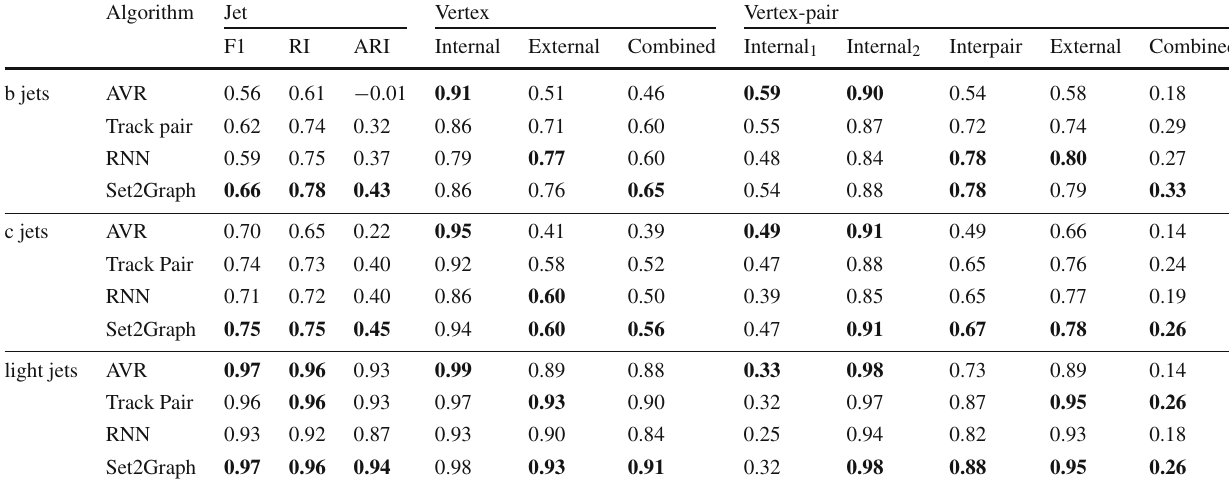
for the S2G, AVR and TP algorithms. The S2G model outperforms or equals the other algorithms, maintaining the baseline AVR high accu-